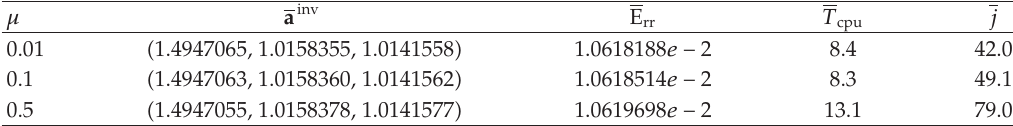
Table 8: Inversion results with regularization parameters for ε (cid:8) 5% .